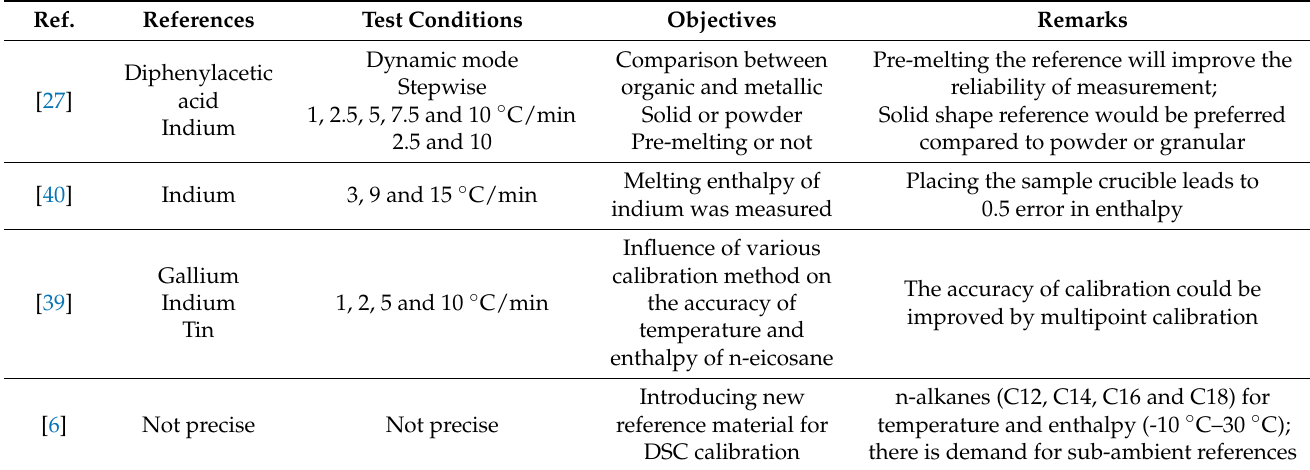
Table 3. Studies on DSC